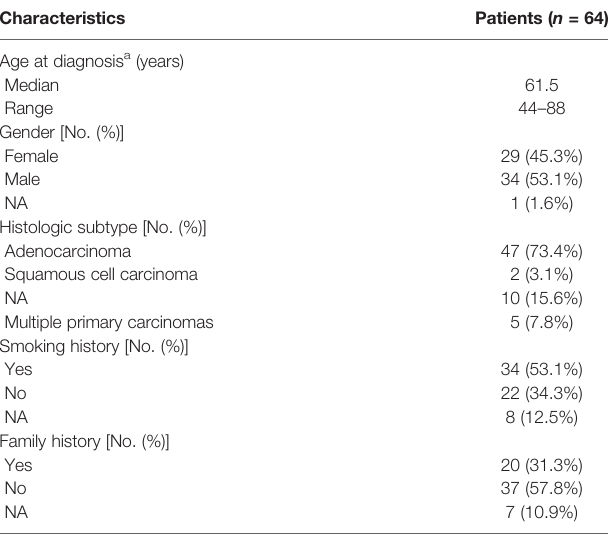
TABLE 1 | Clinical characteristics of patients in the fi nal analysis cohort.